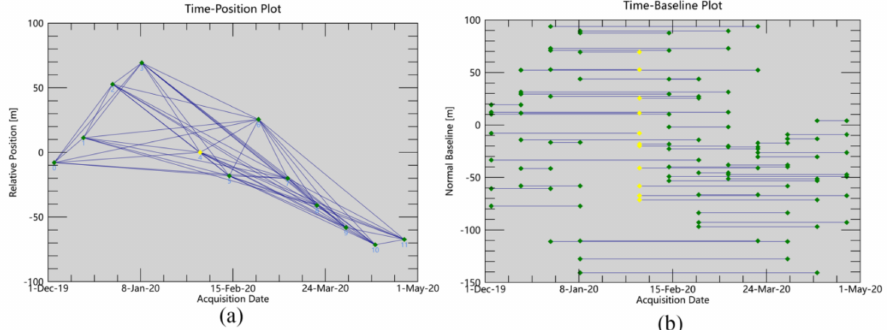
Figure 3. Spatial and temporal baselines utilized in the current study: ( a ) time-position plot of synthetic aperture radar (SAR) image acquisitions; ( b ) time-baseline plot of interferometric pairs of SAR images.